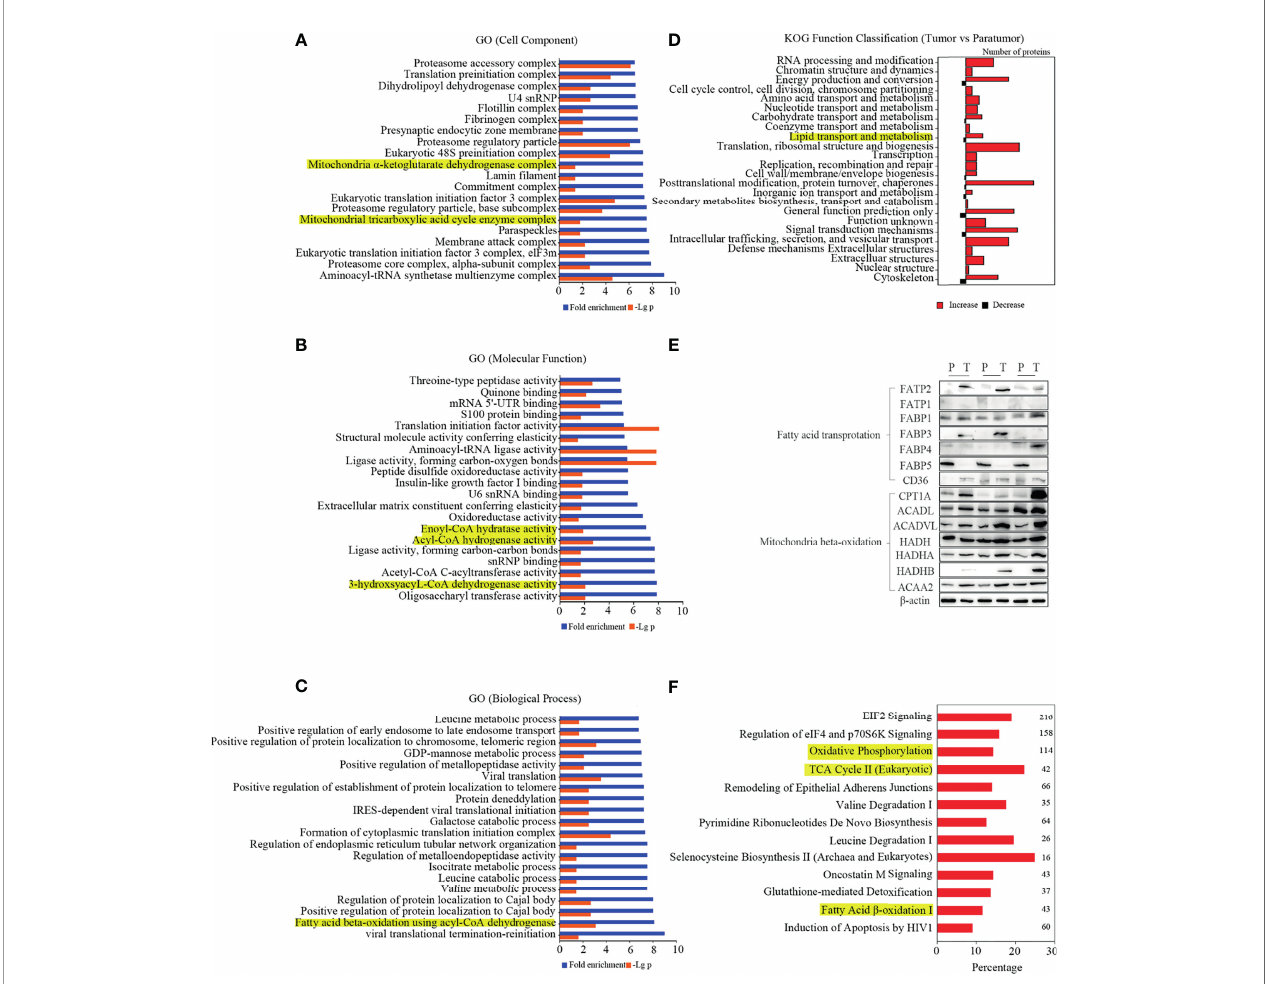
FIGURE 3 | Differentially expressed proteins and pathways in PTC. (A – D) Gene ontology (GO) analysis and Eukaryotic Orthologous Groups (KOG) protein classi fi cations were used to analyse the differentially expressed proteins. The lipid metabolism-related classes were highlighted in yellow. (E) The expression levels of key enzymes in fatty acid metabolism were determined in thyroid cancer and para-tumour specimens by western blot. (F) Upregulated canonical pathways exceeding the threshold [-log(p-value) ≥ 1.3, |Z score| ≥ 2] were displayed in the fi gure. The numbers on the right indicate the count of